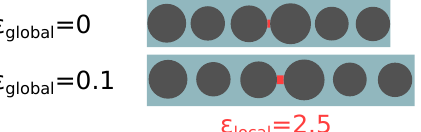
the curves to larger s . The transverse sensitivity reaches a maximum of 0.63.